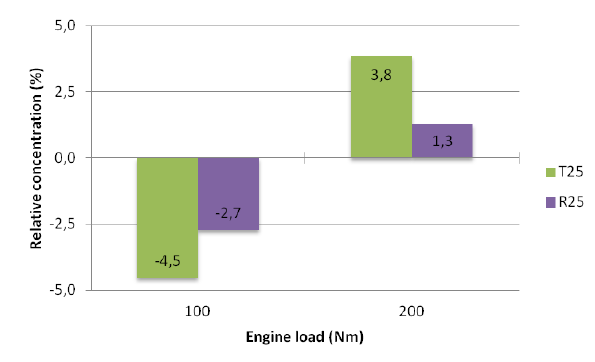
Fig. 6. Hydrocarbons concentration in relation to DF for T25 and R25